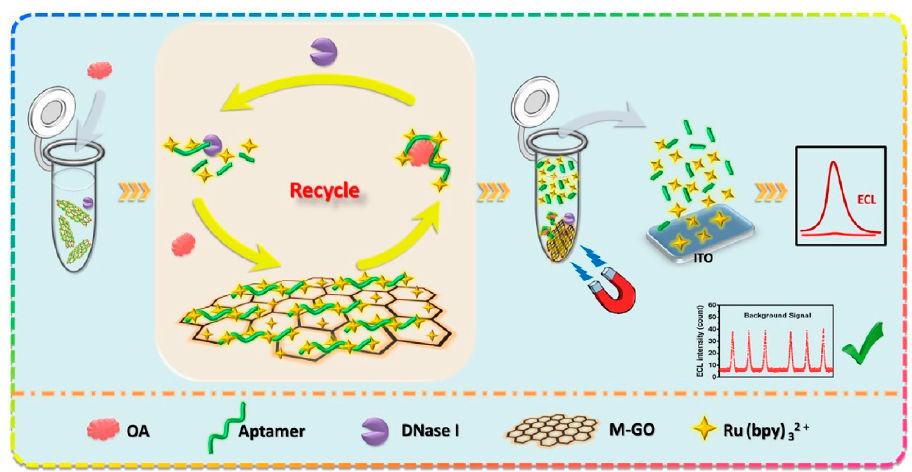
Figure 4. Schematic diagram of the M-GO-assisted homogeneous ECL aptasensor for OA determi- nation. Reprinted with permission from [57] Copyright 2021 Elsevier.